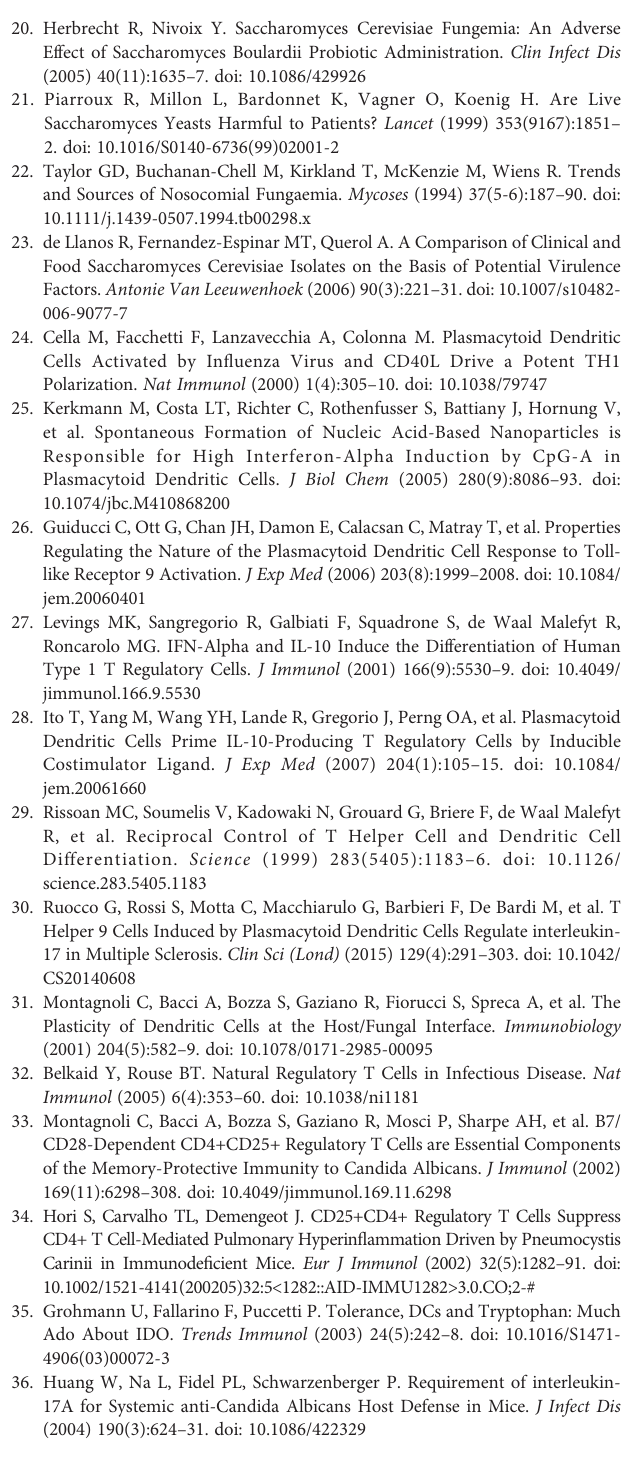
The plots show the data of a representative of all experiments performed with dendritic cells or naïve CD4 T cells. Supplementary Figure 8 | Expression of the yeast receptor in human plasmacytoid dendritic cells (pDCs). The expression values of yeast pattern recognition receptors, cell wall (A) and nucleic acid sensors (B) , on pDCs freshly